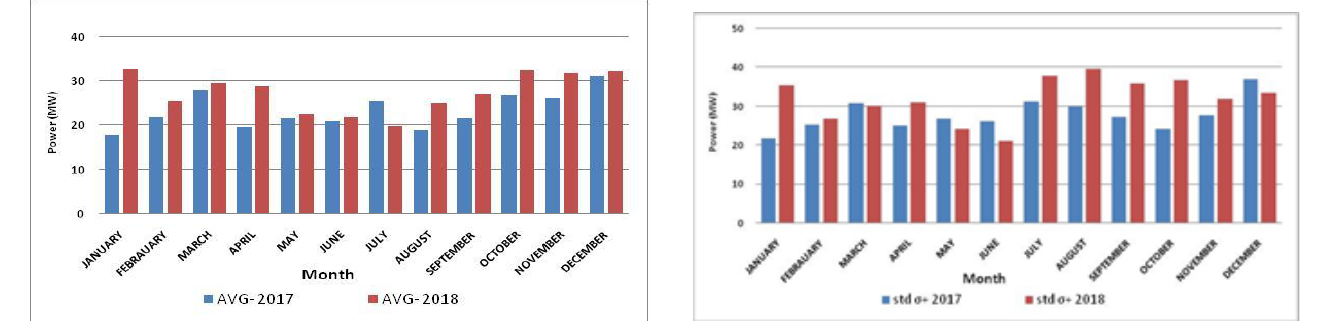
Figure 29. Comparison between standard deviation values of upward power ramps in 15 min interval for each month for years 2017 and